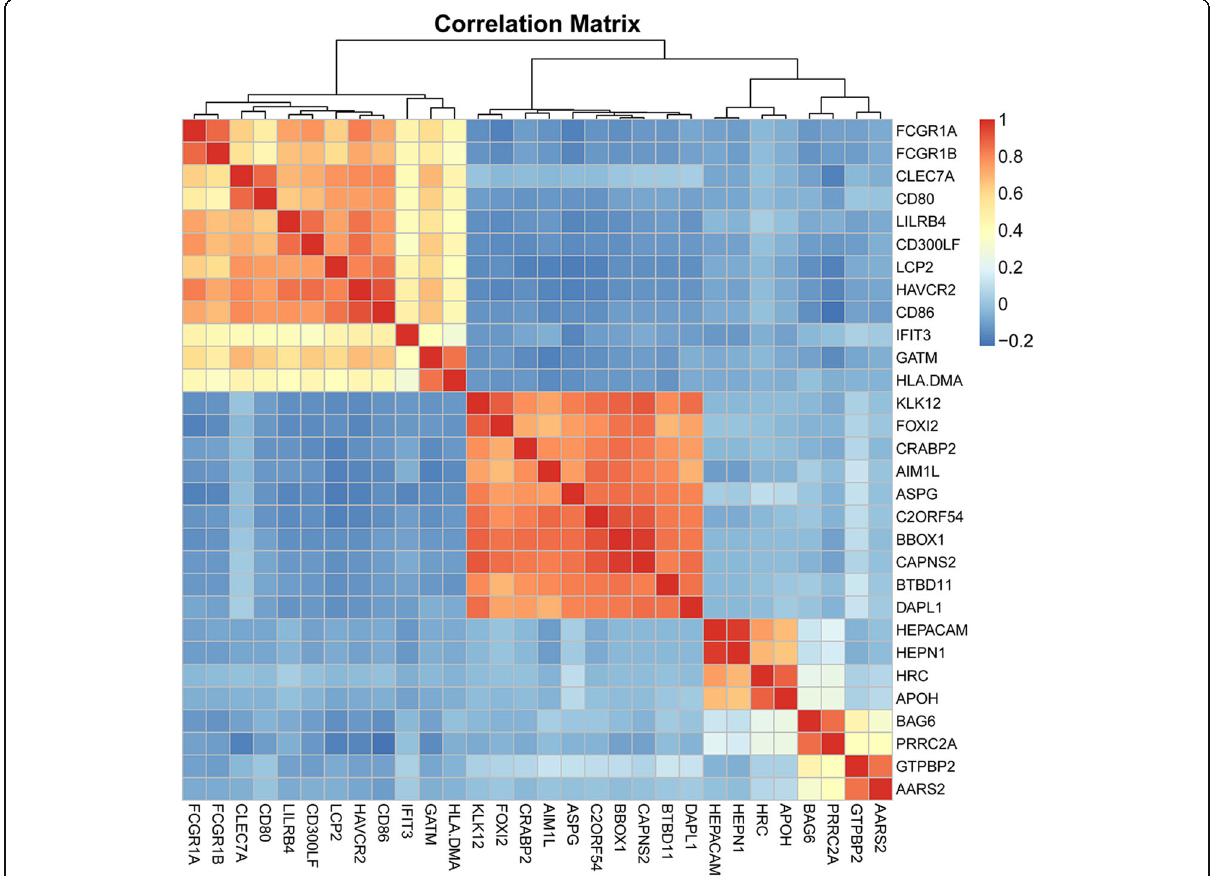
Fig. 1 Heat map of top 30 differentially expressed genes (DEGs) with the highest correlation scores. The labels on the abscissa and the longitudinal axis represent the DEGs. Red squares indicate positive correlation, whereas blue squares indicate negative correlation. Deeper colors indicate stronger correlation